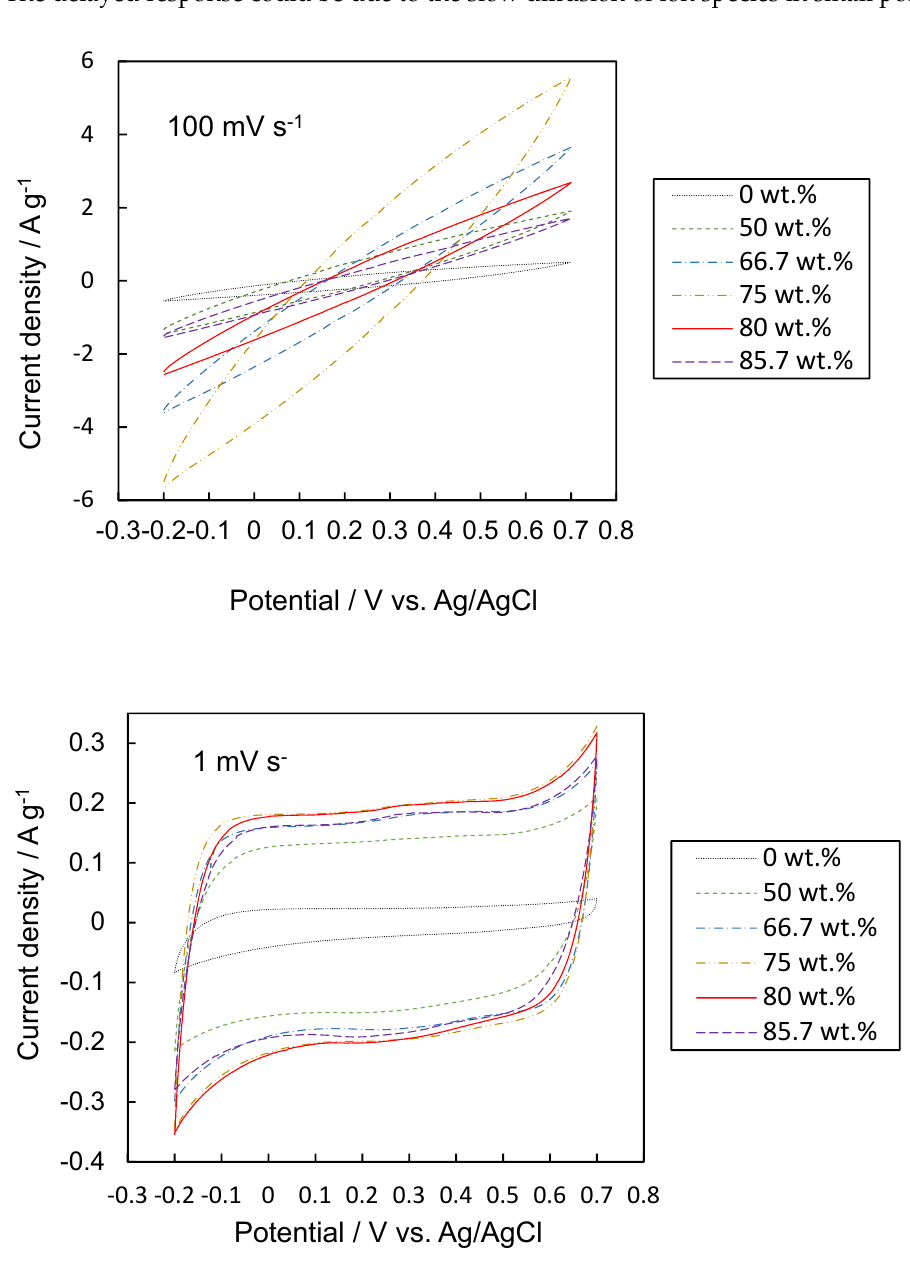
slow response of the current value when the direction of the applied voltage was reversed. The delayed response could be due to the slow diffusion of ion species in small pores.